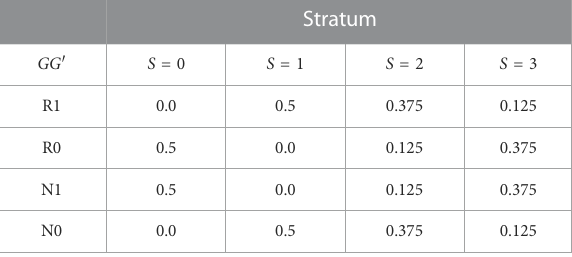
TABLE 1 GG 9 haplotype frequencies in four population strata.